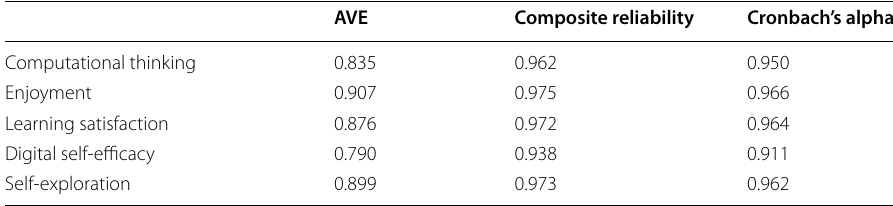
Table 1 Reliability and convergent validity